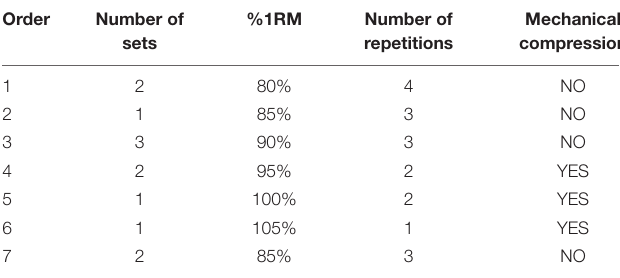
TABLE 3 | A sample training program of the Polish, World, and European champion in the bench press (M.W.). Order Number of sets